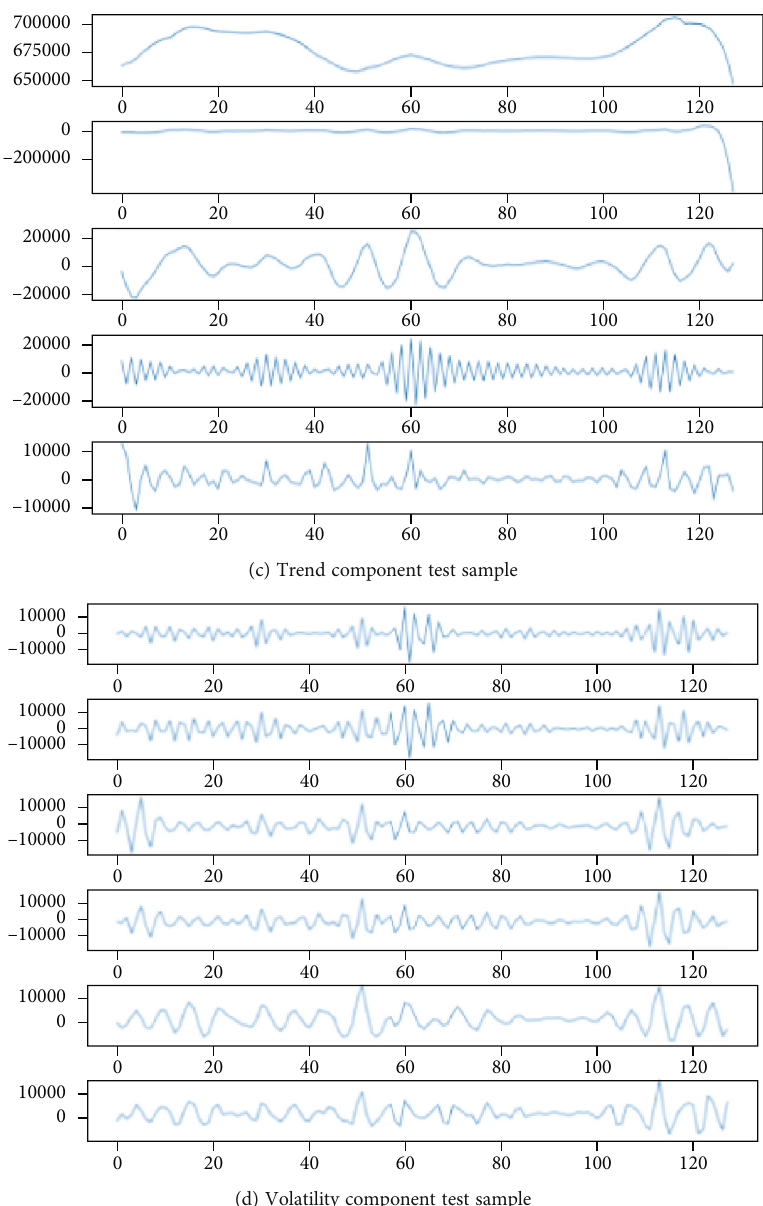
Figure 5: The training samples and test samples of the passenger fl ow sequence data